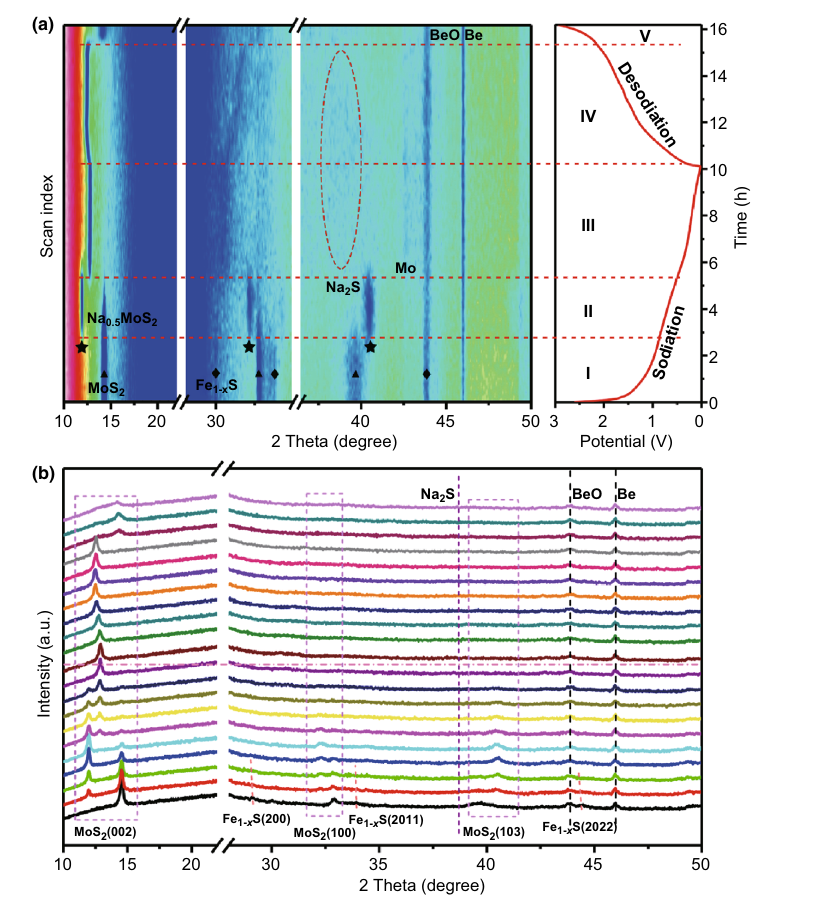
Fig. 4 a Contour plots of in situ XRD results and b selected diffraction patterns of Fe 1− x S/MoS 2 composite electrode during the first sodiation/ desodiation